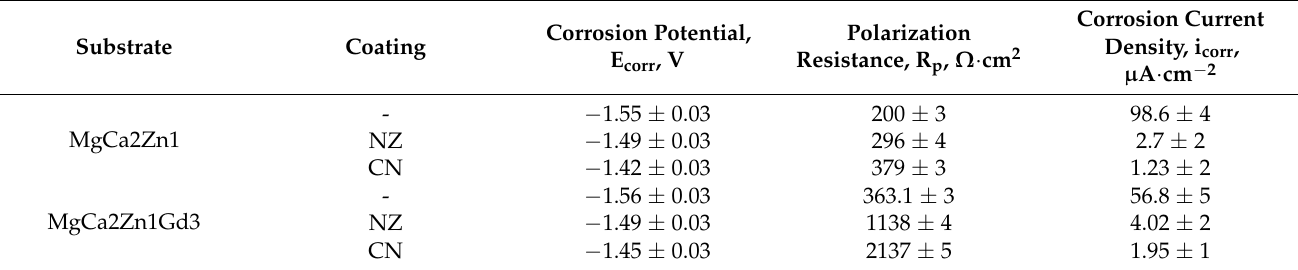
Table 2. Electrochemical parameters of the conversion coating with casein (CN) and casein-free coating (NZ) in the MgCa2Zn1 and MgCa2Zn1Gd3 alloys.